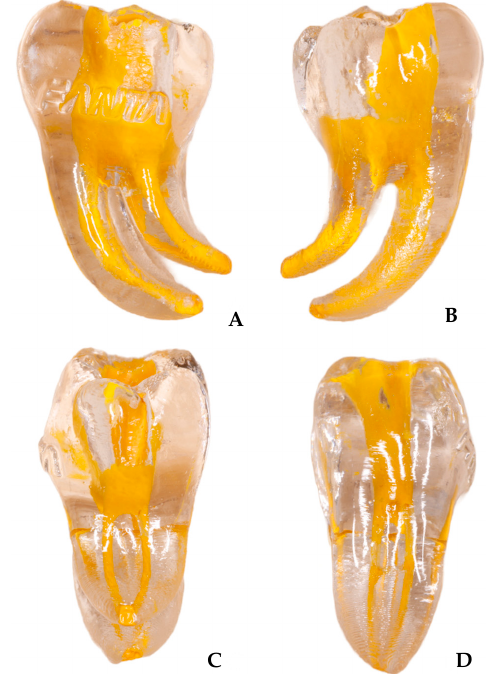
Figure 1. Resin lower molar sample characterized by 4 canals, 2 mesial and 2 distal of 60° of curvature with a radius of curvature of 5 mm. ( A ) vestibular aspect; ( B ) lingual aspect; ( C ) distal aspect; ( D ) mesial aspect.